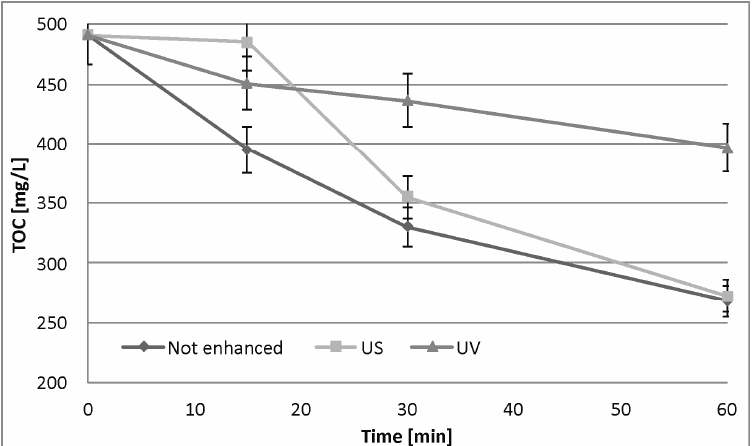
Figure 6. TOC removal during the enhanced Fe 0 /H 2 O 2 process after coagulation at pH 6.0 as pretreatment for 8000/5540 mg/L Fe 0 /H 2 O 2 reagent doses.